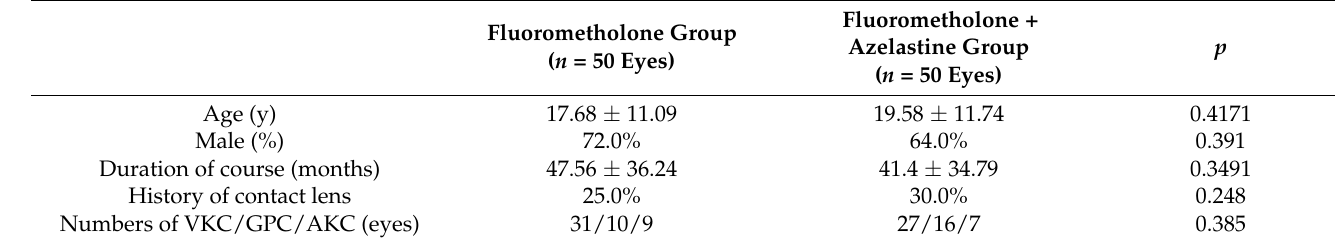
Table 2. Patient demographic characteristics at baseline.